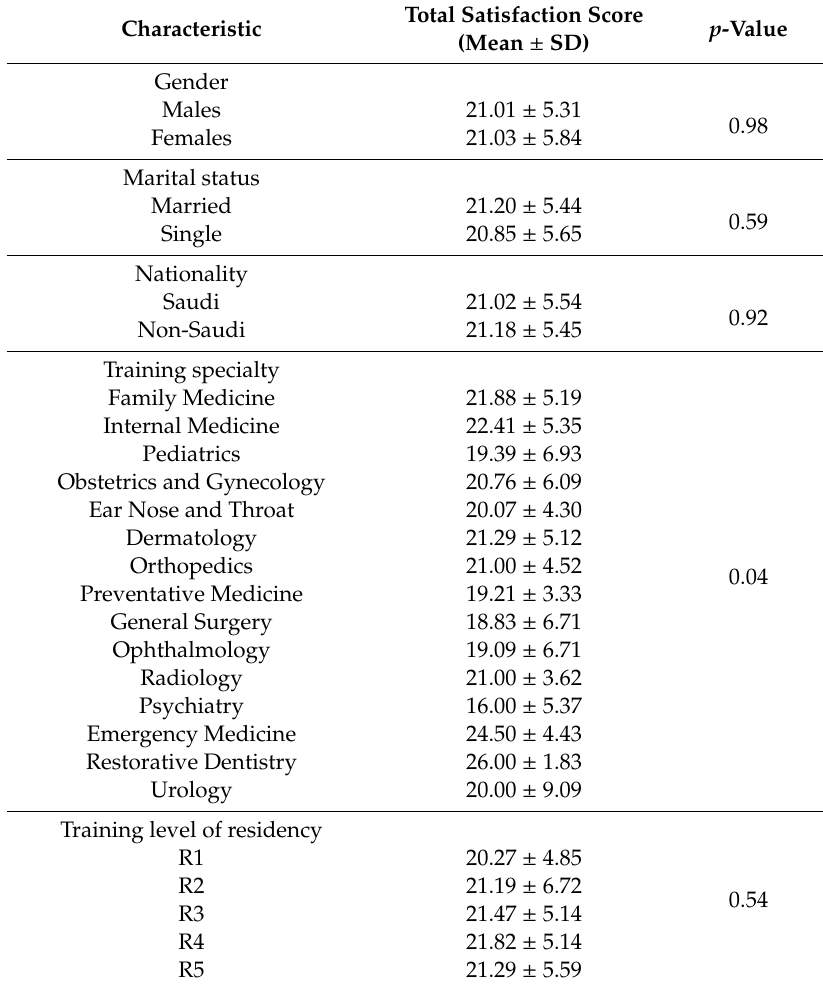
Table 1. Total satisfaction score with continuing medical education (CME) activities among the study residents by their characteristics ( n =